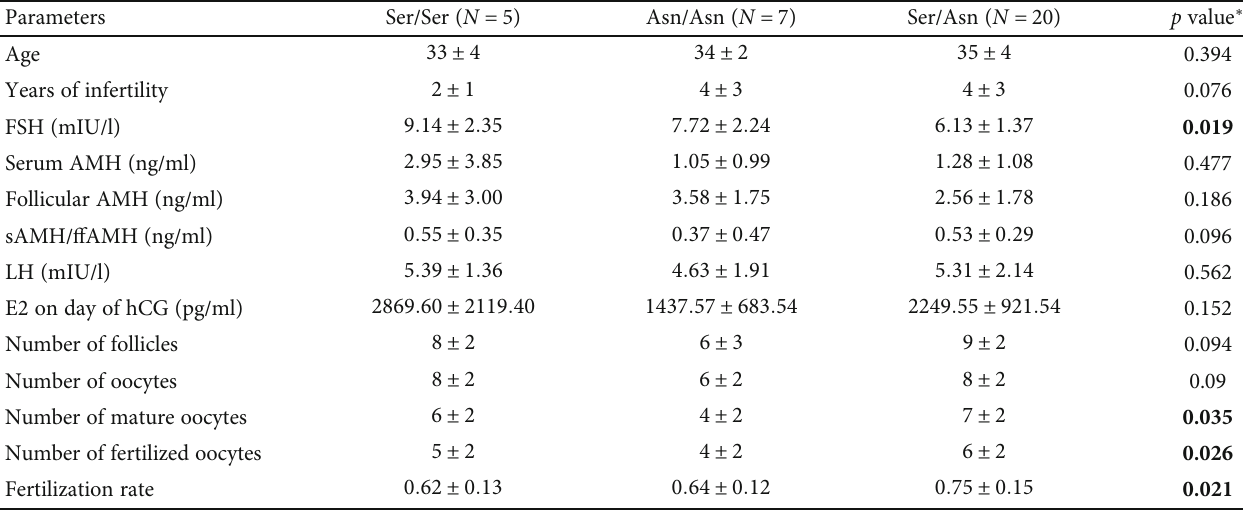
Table 1: Clinical and biochemical characteristics of women of three groups based on the genotype for the polymorphism Ser680Asn of FSH- R. Values in bold are statistically signi fi cant ( p value ≤ 0.05). ∗ One-way analysis of variance (Kruskal Wallis).